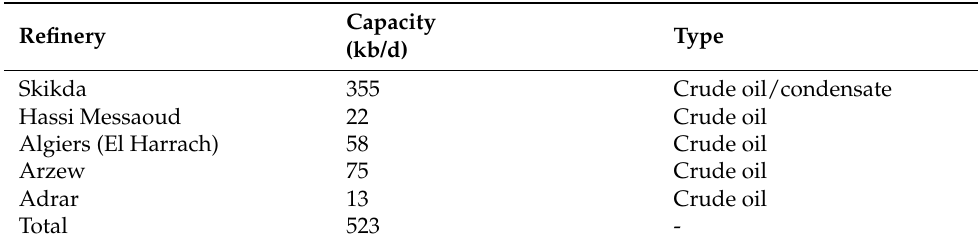
Figure 6. SONATRACH Skikda refinery project. Table 1. Algeria oil refineries [39].